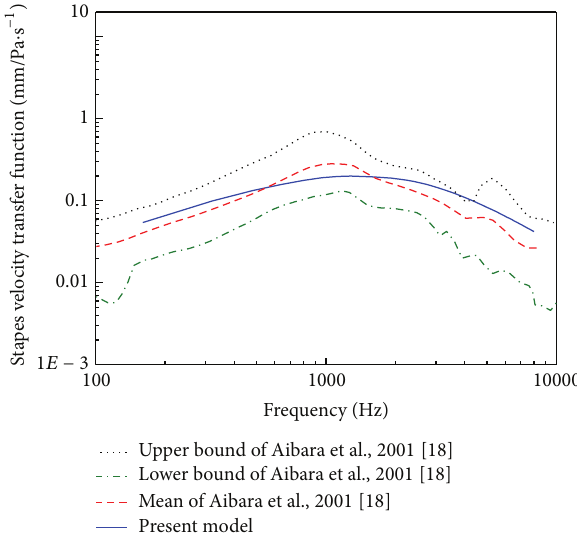
Figure 6: Comparison of the FE model predicted stapes footplate velocity transfer function with the experimental data.